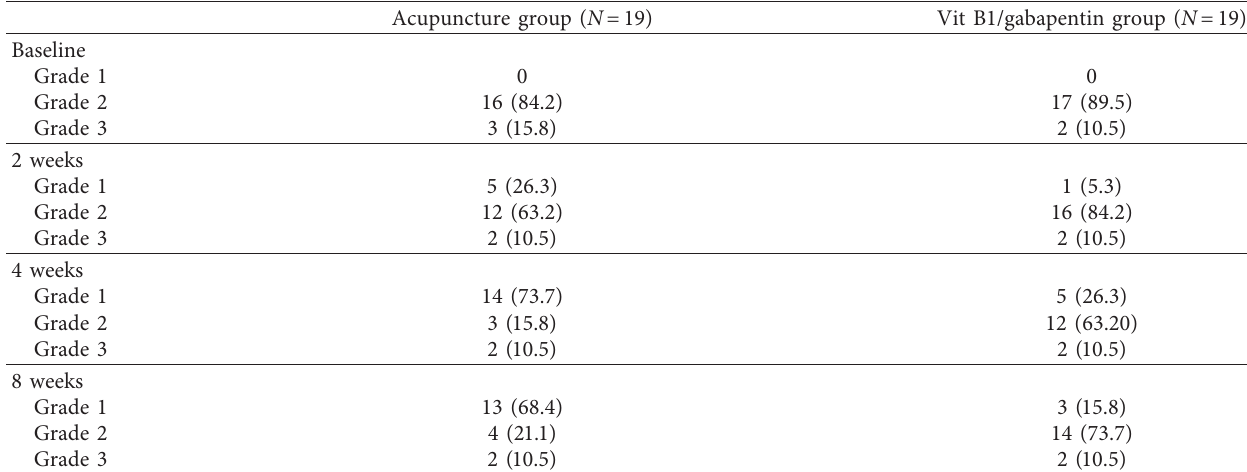
Table 3: NCI-CTCAE sensory neuropathy grading scale over time according to